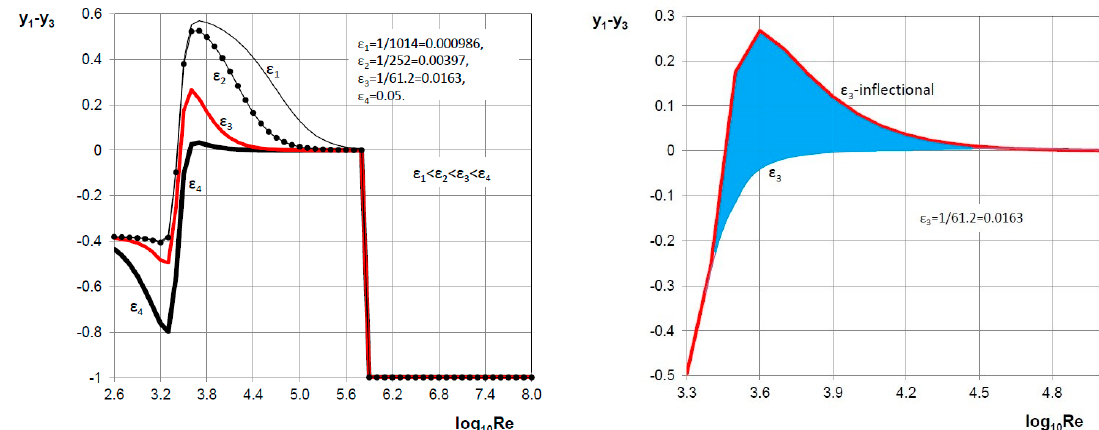
Figure 7. Functions y 1 – y 3, with the main purpose of providing Nikuradse’s inflectional shape of flow friction curves. The right side consists of a magnified detail from the left side; the blue area represents the difference between the Colebrook–White monotonic and the Nikuradse inflectional shapes.